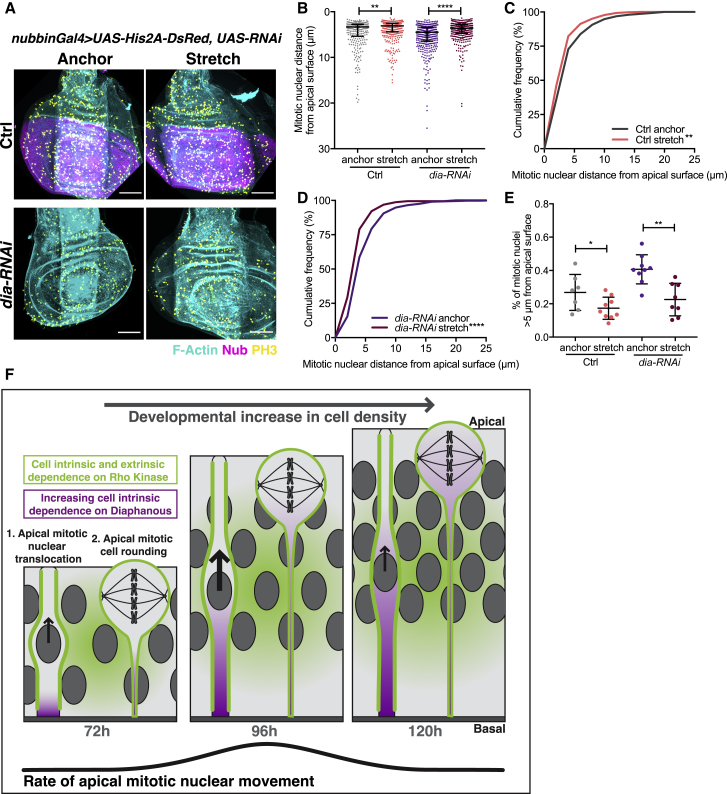
Defects in Nuclear Positioning upon Dia Depletion Can Be Rescued by Mechanically Reducing Cell Density(A) Representative images of mechanically stretched 120 h wing discs, Top: nubbin-Gal4, UAS-Ds-Red control, Bottom: nubbin-Gal4, UAS-Ds-Red, UAS-dia-RNAi, stained with phalloidin (cyan) and anti-PH3 (yellow). Nubbin region shown for control, but present in dia-RNAi. Scale bar, 50 μm.(B–D) Mitotic nuclear distance presented as a dot plot (B) and cumulative frequency distribution (C and D) for control and dia-RNAi wing discs in anchor and stretched conditions.(E) Percentage of translocating mitotic nuclei more than 5 μm from the apical surface for control and dia-RNAi wing discs in anchor and stretched conditions. n = 7 (anchor) and 9 (stretch) wing discs for control and n = 9 (anchor) and 8 (stretch) wing discs for dia-RNAi. Corresponding morphology and normalized PH3 data in Figure S7.(F) Schematic illustrating the influence of developmental increases in cell density and the role of Rok (green) and Dia (magenta) on apical mitotic nuclear movement.Statistical significance: Kolmogorov-Smirnov comparison of cumulative distribution. ∗p < 0.05, ∗∗p < 0.01, ∗∗∗∗p < 0.0001. Error bars: (B), median interquartile range; (E), mean ± SD.